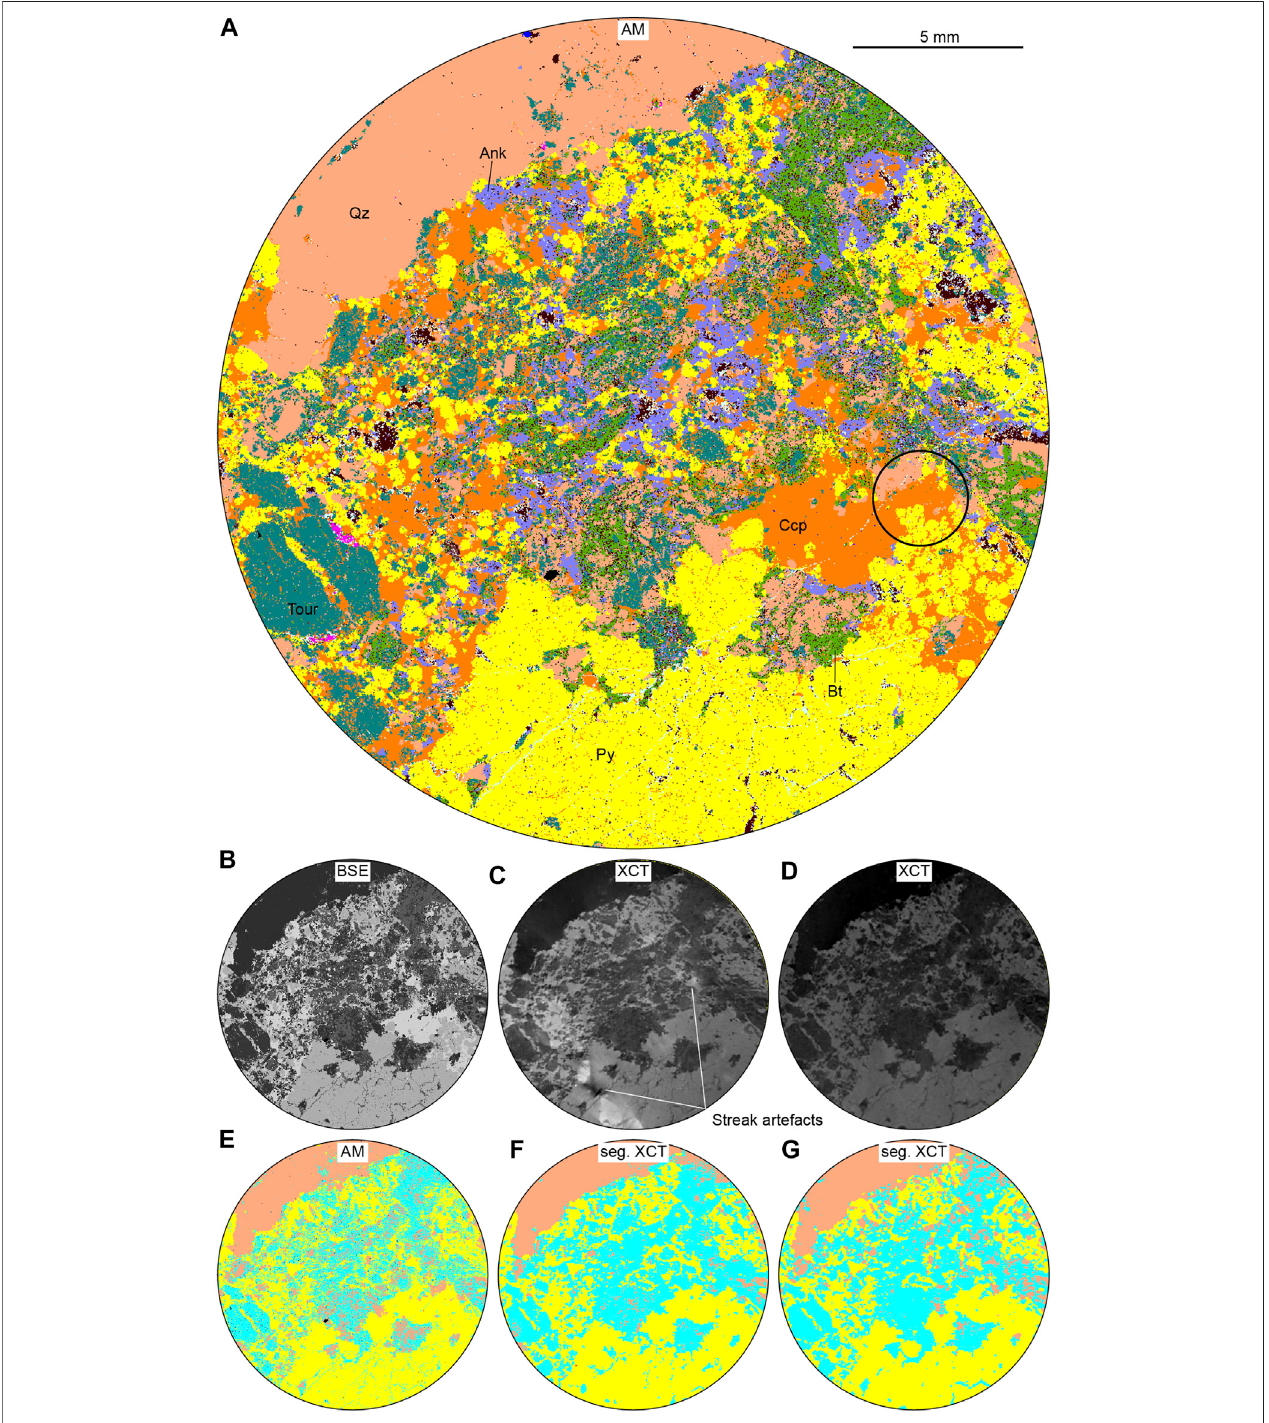
FIGURE 5 | AM and XCT images of a polished rock chip of a mineralized quartz-(tourmaline-calcite) vein (sample 2). For color coding of the minerals, see Table 2 . (A) 30 μ m pixel size AM mineral map. The black circle indicates the overlapping region between the 1 μ m pixel size AM mineral map and the 4 μ m voxel size XCT scan (see Figure 6 ). (B) 1.87 μ m AM BSE image. (C) 30 μ m voxel size XCT scan. The image displays some bright and dark spots, streak artefacts from scheelite in the rock chip of sample 1 because of stacking of the samples for XCT analysis. (D) 45 μ m voxel size XCT scan. (E) Simpli fi ed 30 μ m pixel size AM mineral map. (F) 30 μ m voxelsizesegmentedXCTscan. (G) 45 μ mvoxelsizesegmentedXCTscan.Abbreviations:Ank – ankerite,Bt – biotite,Ccp – chalcopyrite,Py – pyrite,Tour – tourmaline, Qz –